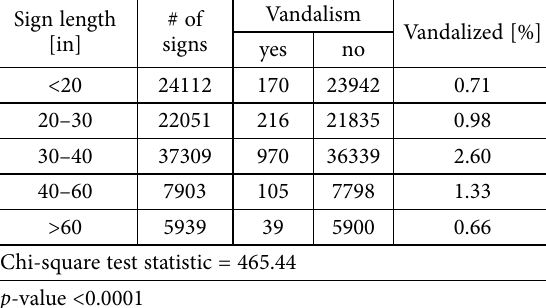
Table 4. Traffic sign vandalism by length